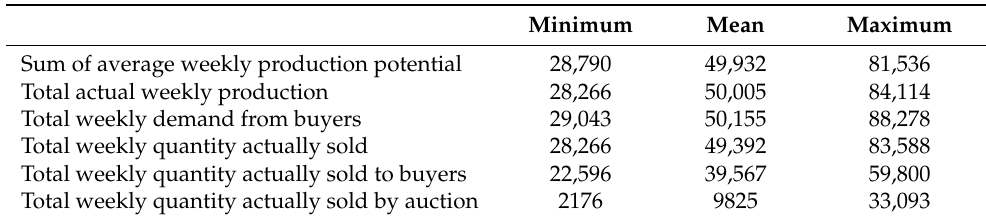
Table 2. Quantities considered in the model and the range of variation in 50 repetitions (thousands of roses per